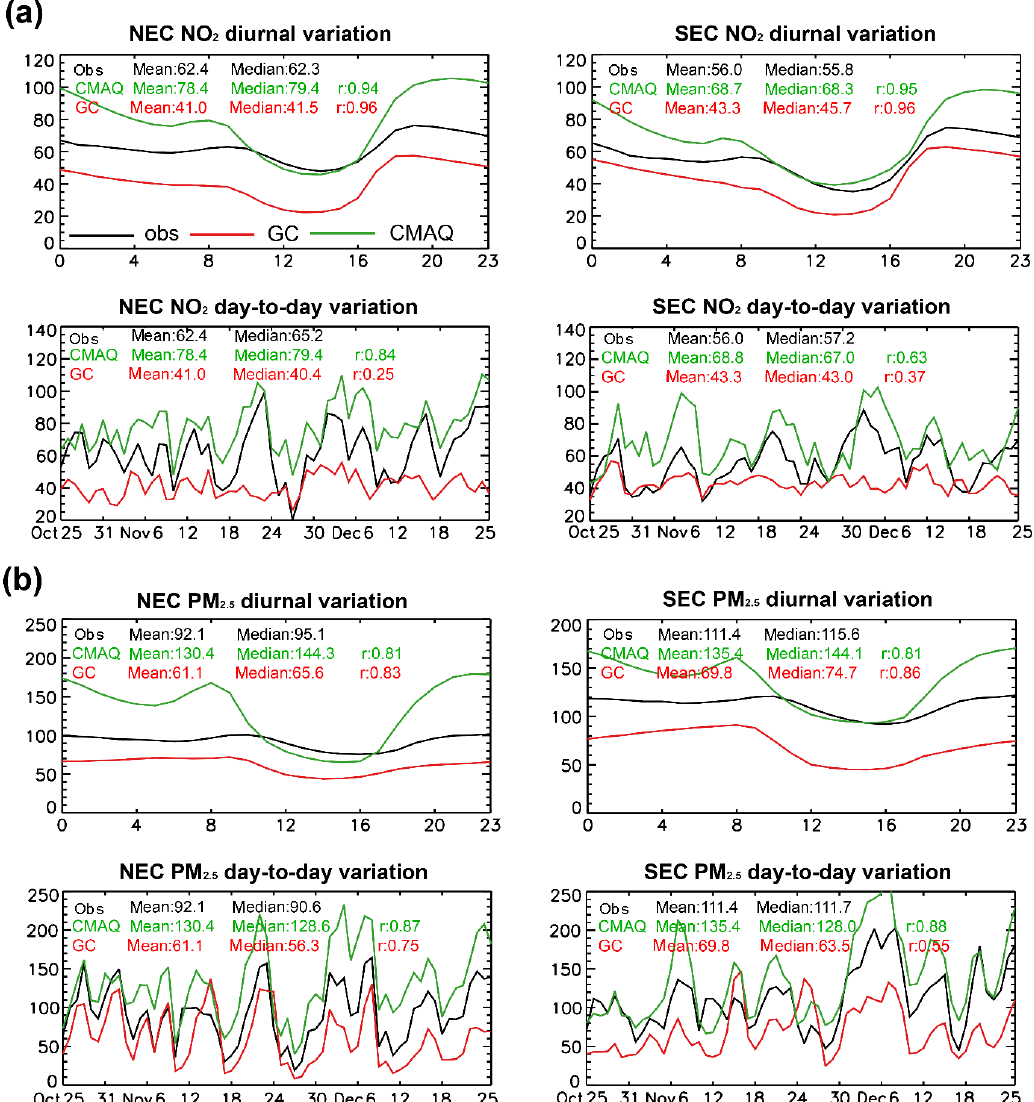
Figure 9. Observed and simulated diurnal and day-to-day variations of (a) NO 2 and (b) PM 2 . 5 over NEC and SEC (µgm − 3